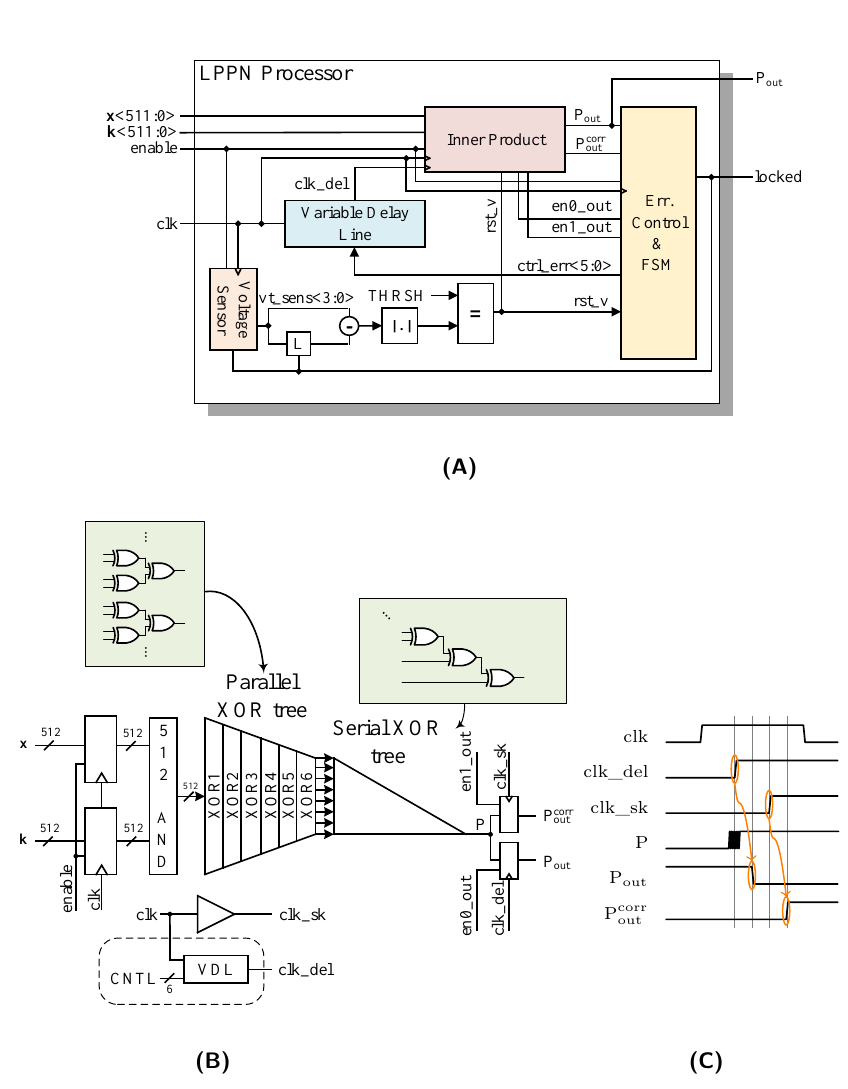
Figure 3: Architecture of the LPPN processor (A). Details of the inner product network (B) and corresponding timing diagram for inexact sampling